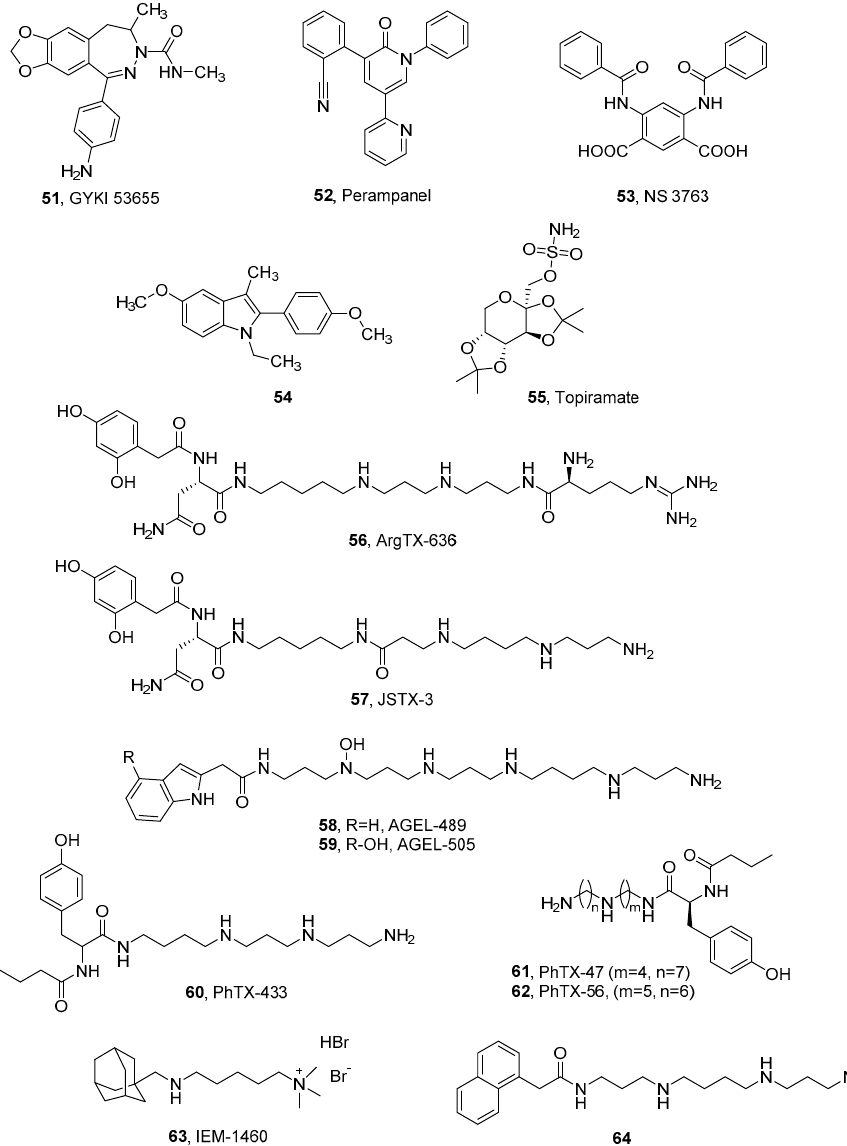
Figure 8. Non-competitive antagonists and channel blockers of kainate receptors. Inhibition of iGluR activity could also occur as a result of the binding of ion channel blockers. Among this group of derivatives, many naturally occurring compounds, as well as their synthetic analogs, have been described. All shared structural similarity (that is, polyamine moiety) and, when applied, blocked the AMPAR/KAR in a voltage-independ- ent manner [193]. Within the KAR family, the GluK3 subunit demonstrated significant sensitivity to polyamines, especially compared to the GluK1 and GluK2 subunits. Mean- while, auxiliary proteins of the kainate receptors, NETO1 and NETO2, attenuated the blocking of ion channels [194]. As mentioned above, permeability to Ca 2+ as well as an affinity of polyamines is related to the editing of the Q/R site, where the kainate receptors of the “R” type are not permeable to Ca 2+ and show no sensitivity to polyamines [16,17,195]. This effect was considered to derive from the electrostatic repulsive effect of positively charged arginine in the narrowest region of the pore. GluK4- and GluK5-